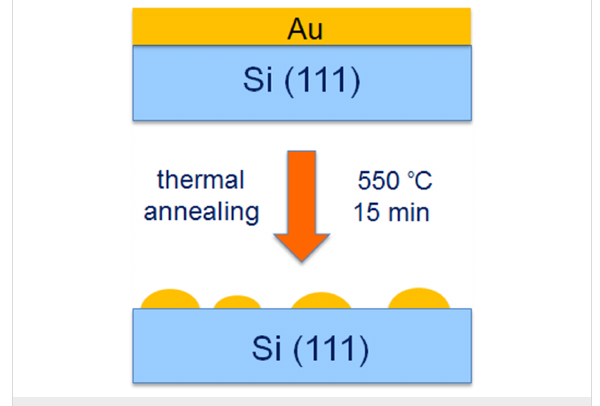
Figure 1: Scheme of the formation of the gold